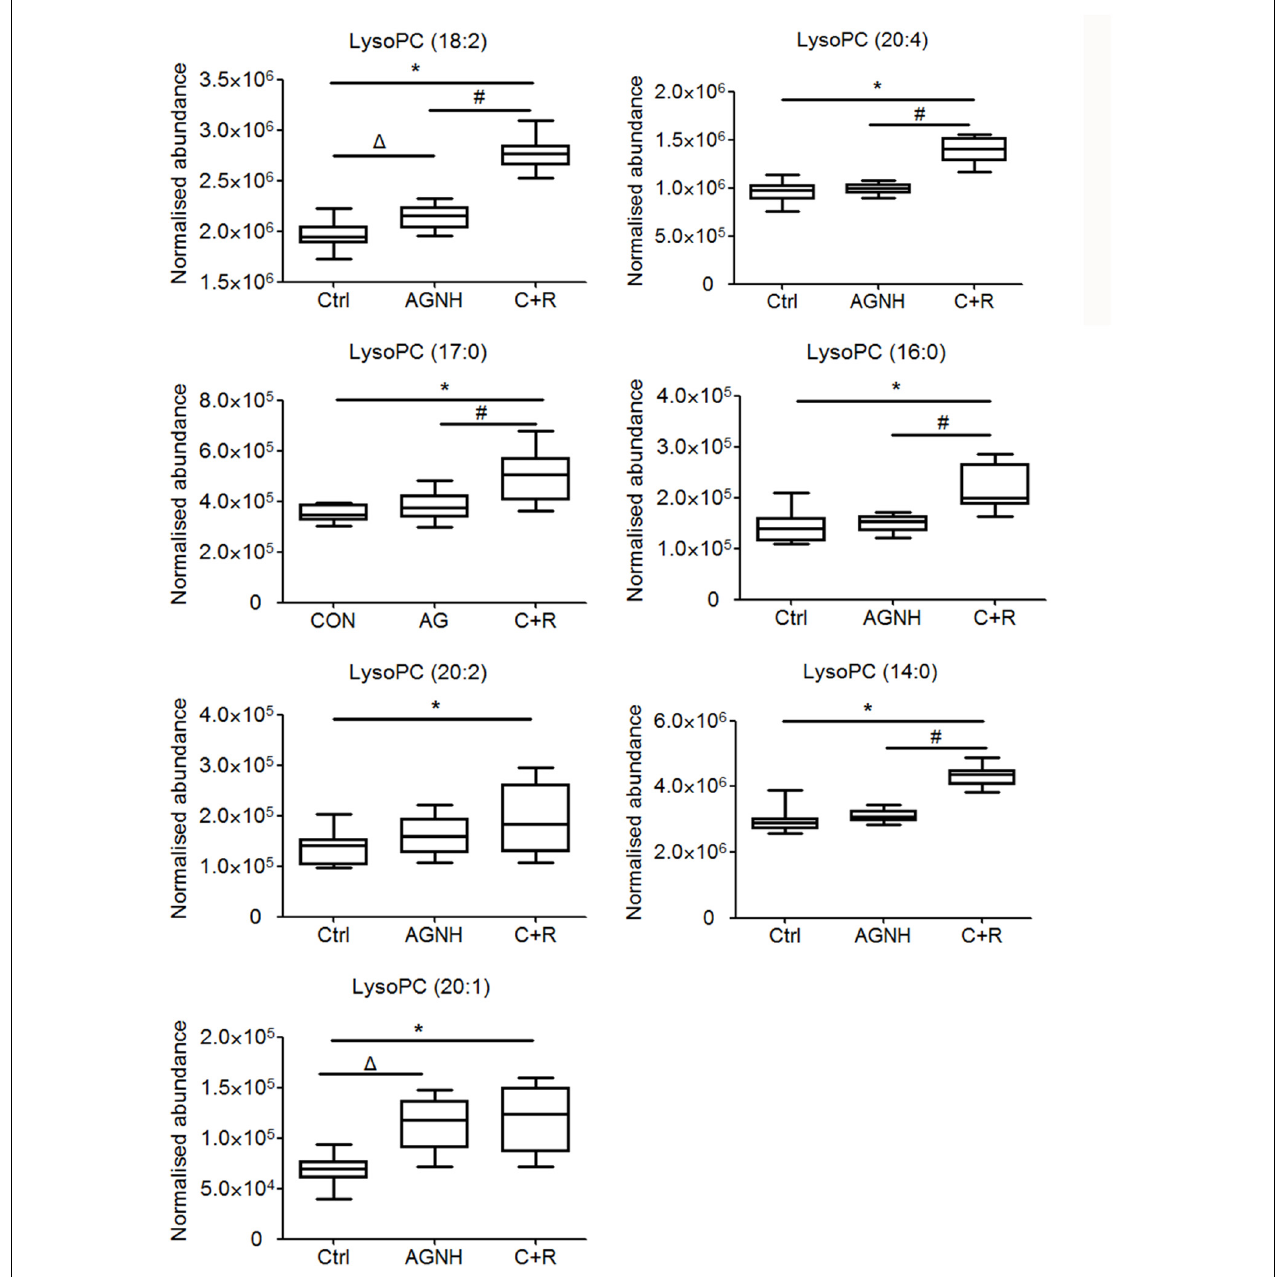
FIGURE 7 | The content of lysophosphatidylcholines (LysoPCs) in sera of mice from saline control (Ctrl), An-Gong-Niu-Huang Wan (AGNH) and cinnabar and reaglar co-administration (C + R) groups. ∗ P < 0.05 saline control versus cinnabar and reaglar co-administration; # P < 0.05, An-Gong-Niu-Huang Wan versus cinnabar and reaglar co-administration; (cid:49) P < 0.05, saline control versus An-Gong-Niu-Huang